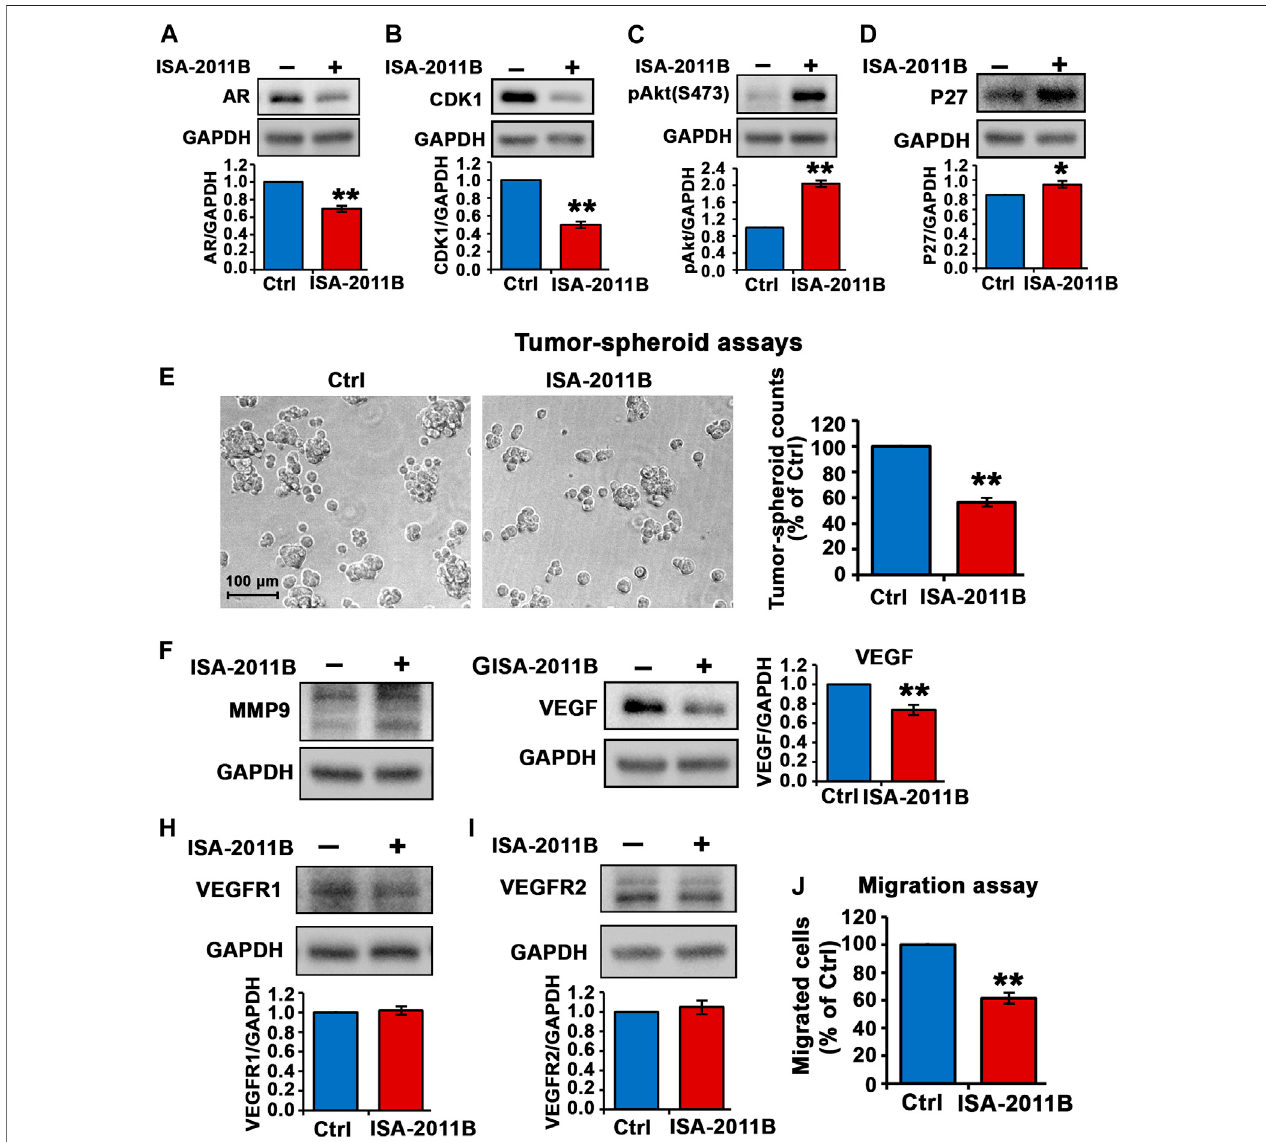
FIGURE 4 | Inhibition of total PIP5K1 α by its inhibitor ISA-2011B on functional pathways in DU145 cells. (A – D) The effect of ISA-2011B on the expression of AR, CDK1, pAKT and P27 in DU145 cells was determined using immunoblot analysis. Quanti fi cations of the immunoblots are shown in the lower panels. (E) Representative images of tumor spheroids derived from DU145 cells treated with ISA-2011B or vehicle control were taken by using light microscope. The counts of tumor spheroids derived from DU145 cells treated with ISA-2011B or vehicle control are shown in the right panel. (F – I) The effect of ISA-2011B on expression of MMP9, VEGF, VEGFR1 and VEGFR2 in DU145 cells was determined using immunoblot analysis. Quanti fi cations of the immunoblots are shown. (J) The effect of ISA-2011B on the migratoryabilityofDU145cellswasdeterminedusingmigrationassays.Datainthis fi gureispresentedastheaverageofthreeindependentexperiments(±SE).Student ’ s t -test was used in the analysis. * p < 0.05 or ** p < 0.01 are indicated.